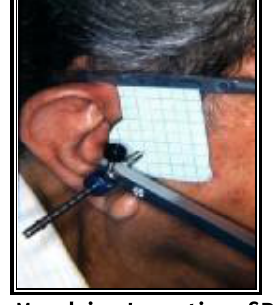
Figure 5: Marking Locationof Pin Point on the Flag's Graph